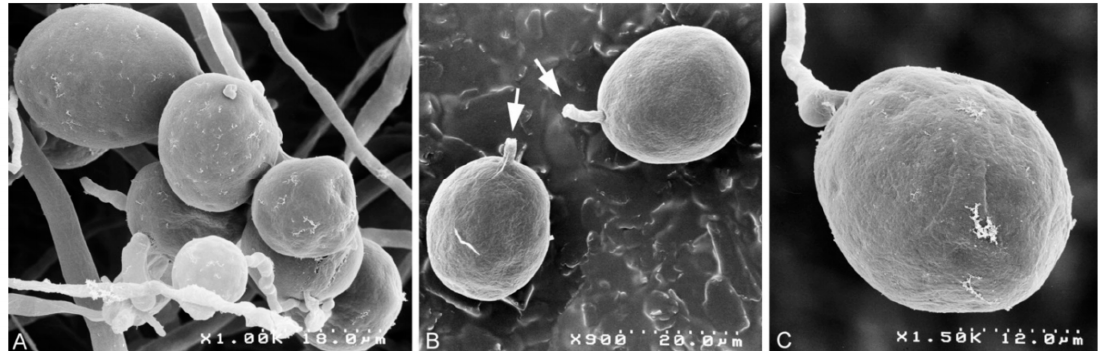
Figure 4. Scanning electron microscopy (SEM) images of pseudoconidia formed by Phytophthora heterospora on carrot agar: ( A ) cluster of pseudoconidia; ( B ) detached globose pseudoconidia with short pedicels (arrows); ( C ) ovoid pseudoconidium still attached to the conidiophore. Magnifications and scale bar dimensions are given in the right-bottom